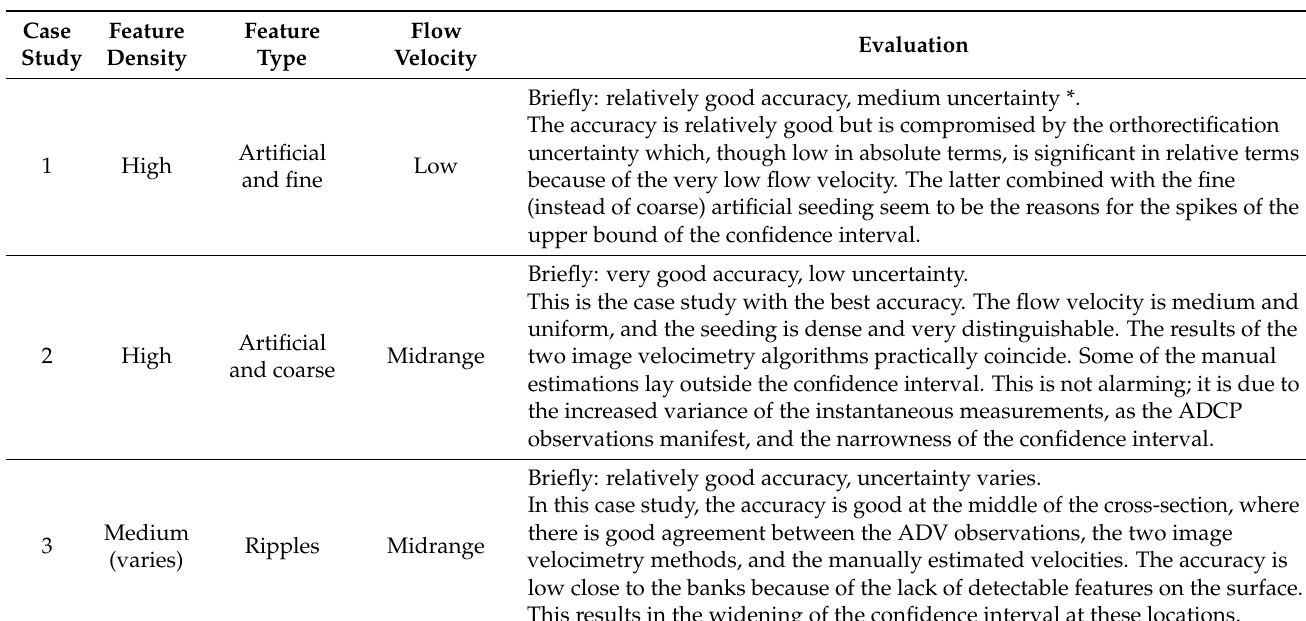
Table 1. Evaluation of LSPIV accuracy under various conditions. Case study 1: Kolubara River, 2: Murg River, 3: Salmon River, 4: Loussios River at Atsicholos Bridge, 5: Loussios River upstream Atsicholos